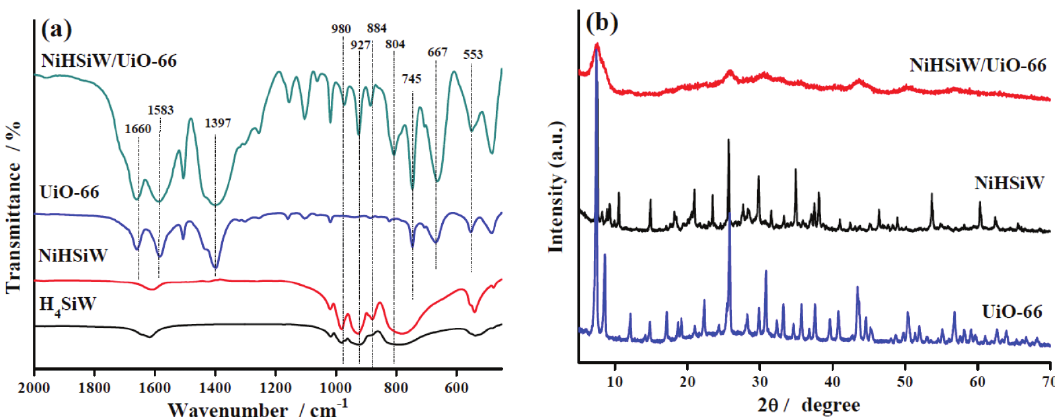
SiW, NiHSiW, UiO-66 and NiHSiW/UiO-66 samples; (b) XRD spectra of 4